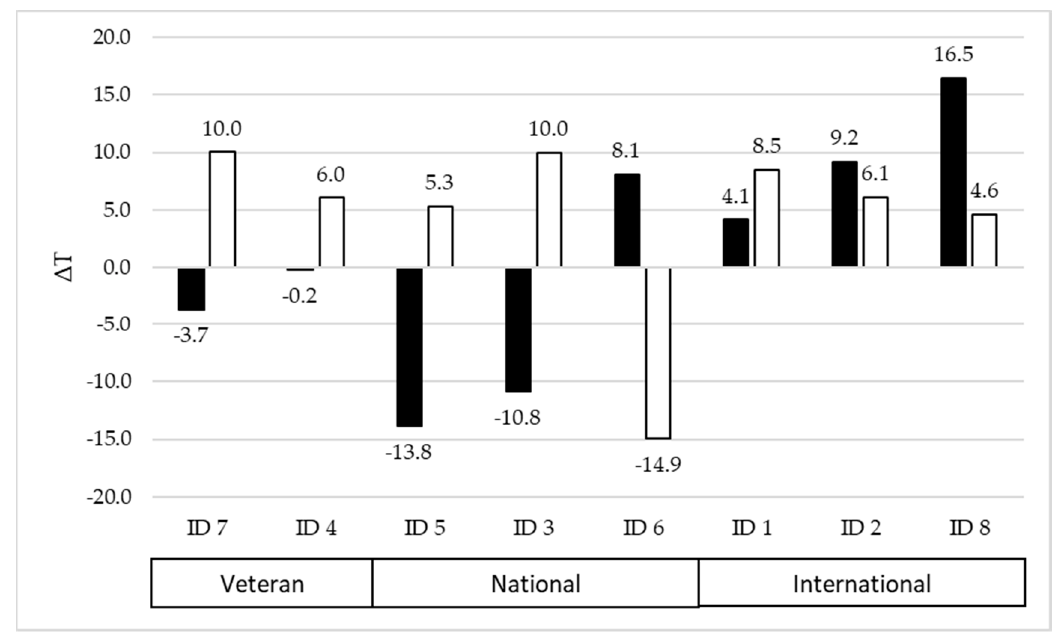
Figure 2. Temperature variations on the fencing uniform sorted per competition level. In black it is reported ∆ T 12 , while in white ∆ T 23 . It can be noticed that temperature variations for veteran athletes are generally lower than for the others (especially ID 4). National athletes were presenting high ∆ T, with the tendency to reduce and then increase their temperature. The only exception is ID 6, who presented the opposite trend. International athletes were presenting a constant increase of temperature.